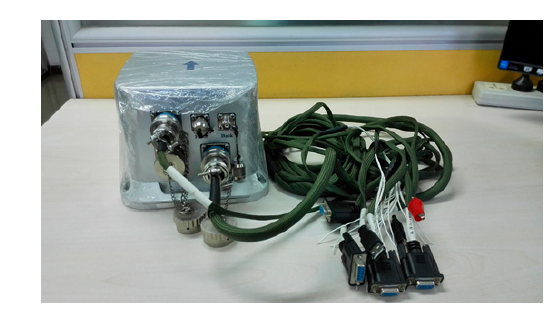
( b ) Figure 5. Photographs of the experimental vehicle. ( a ) Inner; ( b ) Exterior. 4.2. Open-Sky Route Field vehicle experiments of open-sky route were conducted in Beiqing Road, Haidian District, Beijing, China. Figure 6 shows a map of the experiment route. The start point is marked by a red